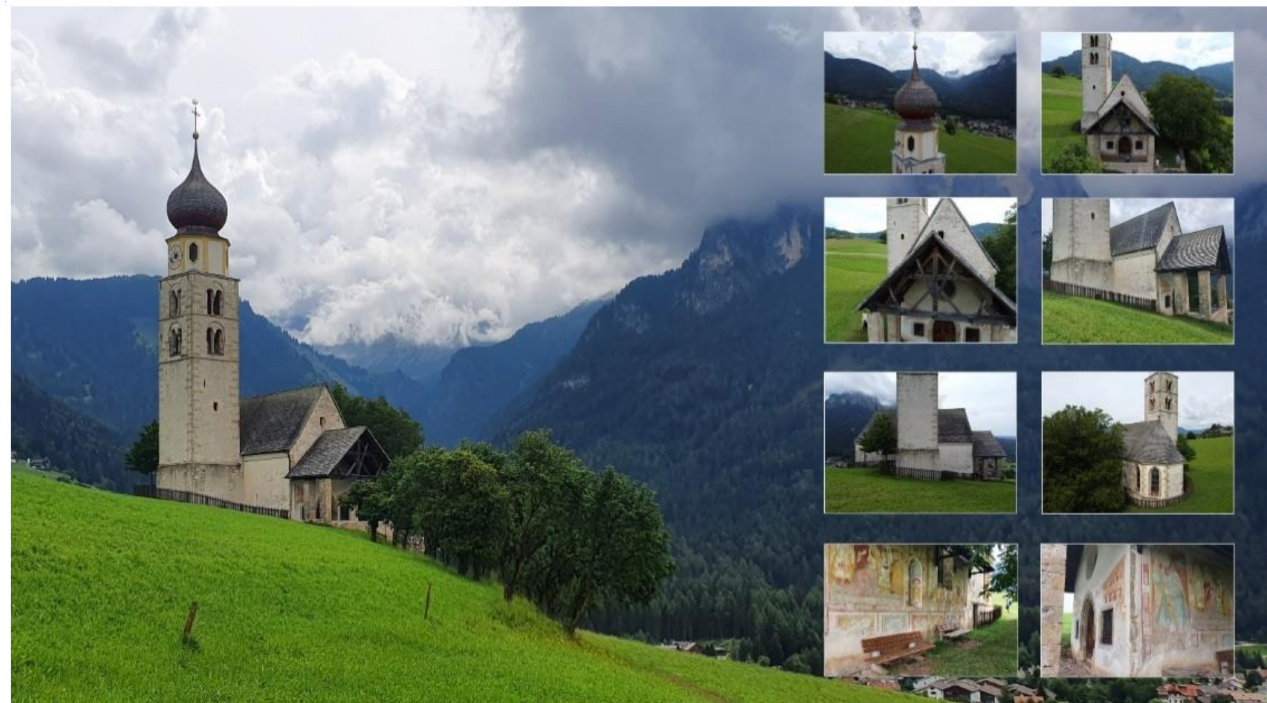
Figure 2. External views from UAV of San Valentino church, Siusi in Castelrotto, Italy. Both on the west side and the south side of the church, there were frescoes. To the west, there was a ribbon with depictions of the 14 Helpers. While only the heads are now visible on the left, the four saints on the right side can be identified based on the partially preserved attributes. From left to right, they are S. Barbara (tower), S. Dorotea (basket), S. Caterina (wheel) and S. Margherita (dragon). Above the Annunciation is depicted within a trilobite. The frescoes on the south wall are largely preserved excellently. They show— from west to east—St. Christopher and the Adoration of the Magi. Above the walled-in window, it is possible to see the shroud of Christ. There follows a depiction of the partially destroyed Crucifixion, next to the Madonna enthroned with Child and the patron saint of the Church, S. Valentine of Terni. The lively representation of the figures as well as the attempt to insert them in a representation of the landscape, indicate a master of the Bolzano school, active at the end of the 14th century under strong Veronese influence. The nave is covered by two naves of a reticulated vault, whose ribs at the room’s corners rise from shelves carrying masks. At the top of the vault is a key with the coat of arms of the nobles of Zwingenstein. The other ribs of the vault rest on octagonal servants. A triumphal arch joins the nave and choir. The rib vault in the chorus is clearly better shaped than the one in the nave (Figure